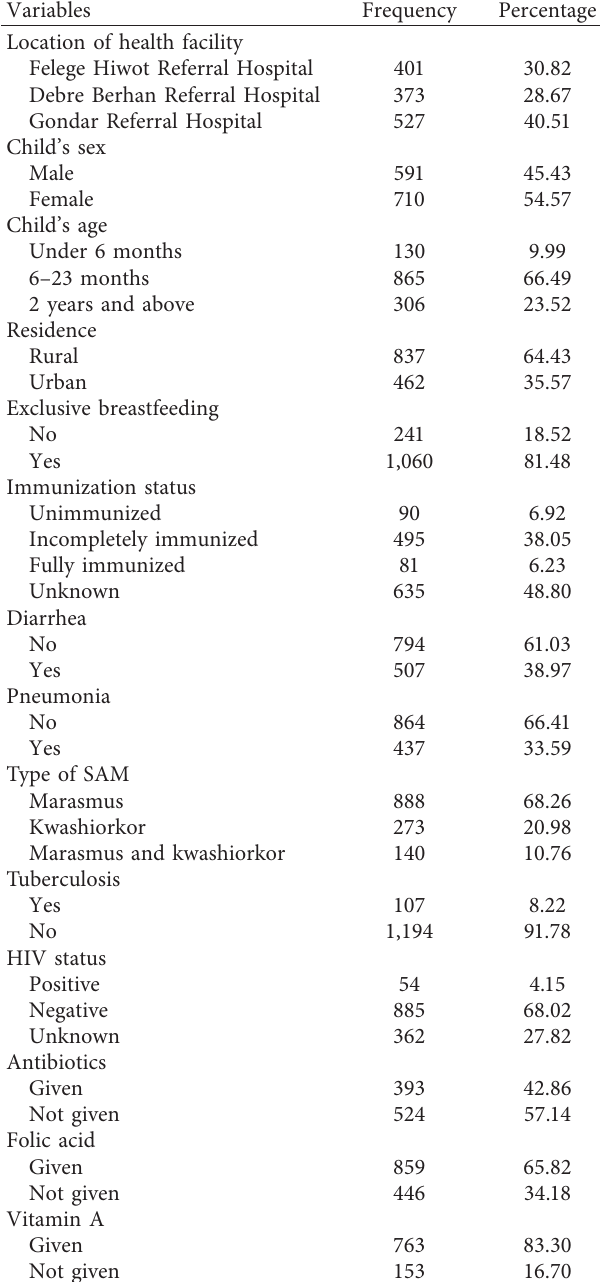
Table 1: Sociodemographic characteristics of children with SAM in the Amhara region, northwest Ethiopia,